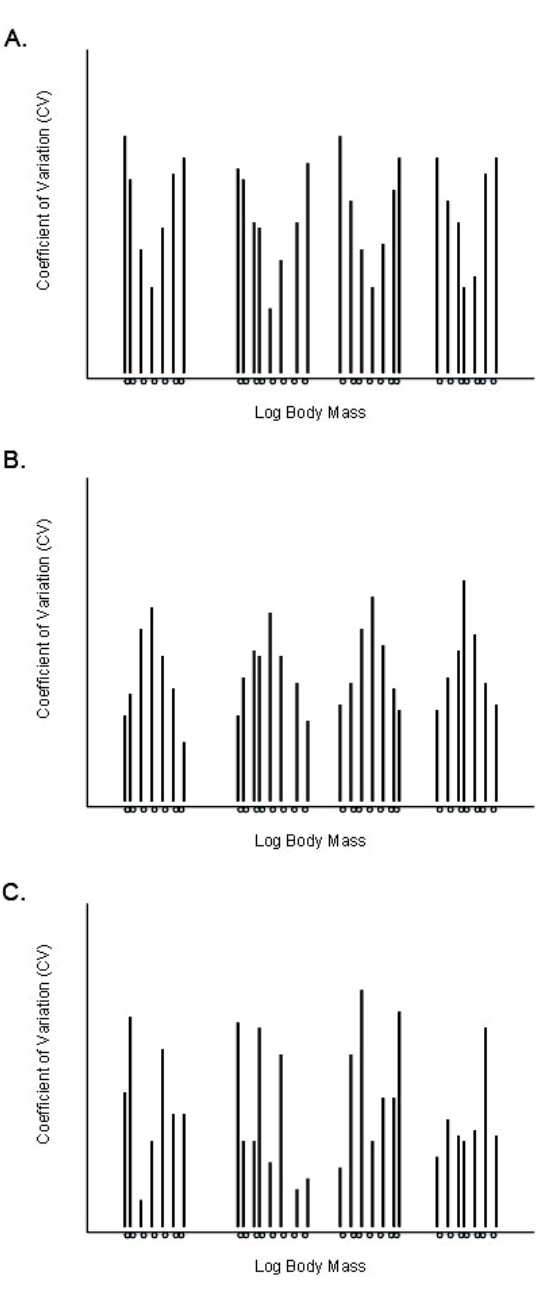
Fig. 3. Possible relationships between coefficient of variation (CV) in population abundance in time and space and position of species body mass relative to discontinuities. A) CV is larger in species proximal to discontinuities. B) CV is smaller in species proximal to discontinuities. C) CV is random with respect to proximity to